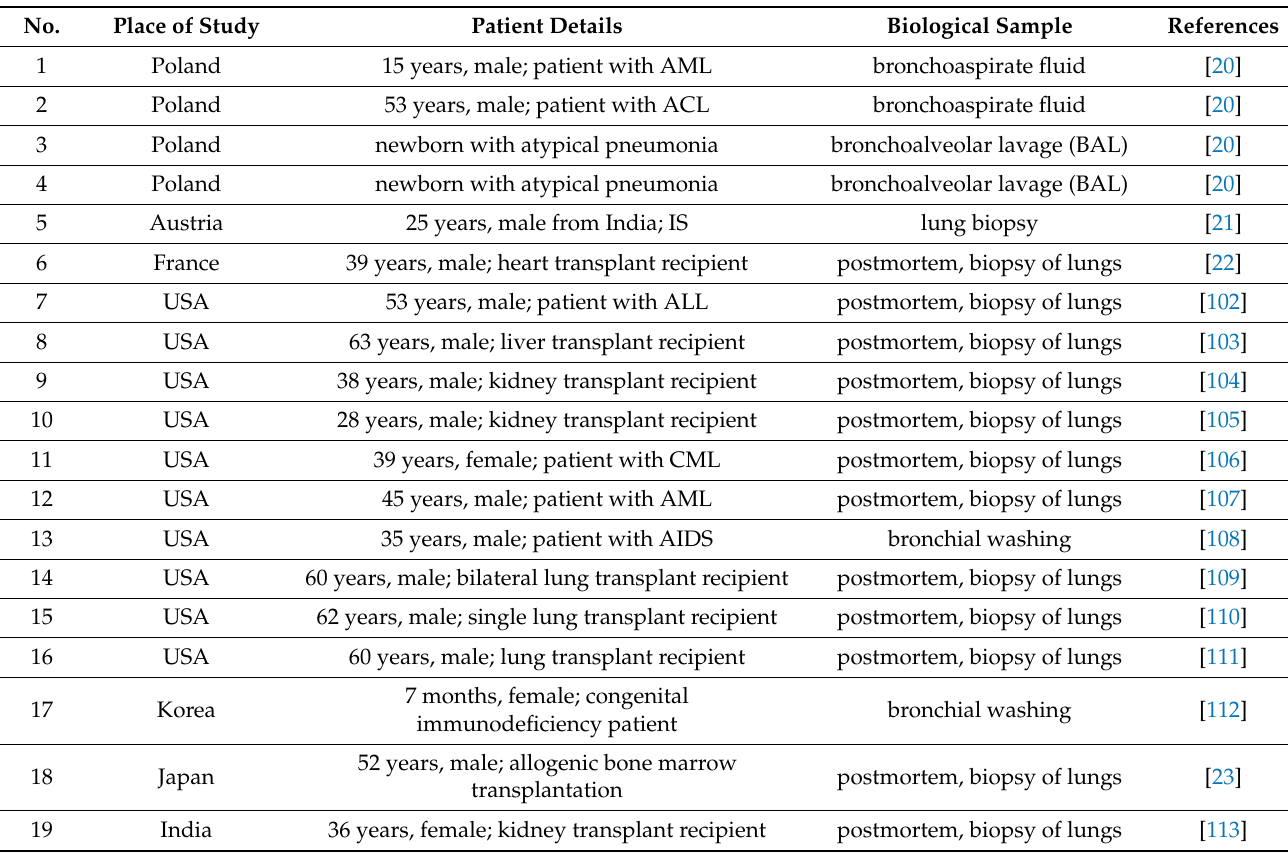
Table 2. Cases of Acanthamoeba pneumonia (AP) or disseminated acanthamoebiasis with lung infection reported during